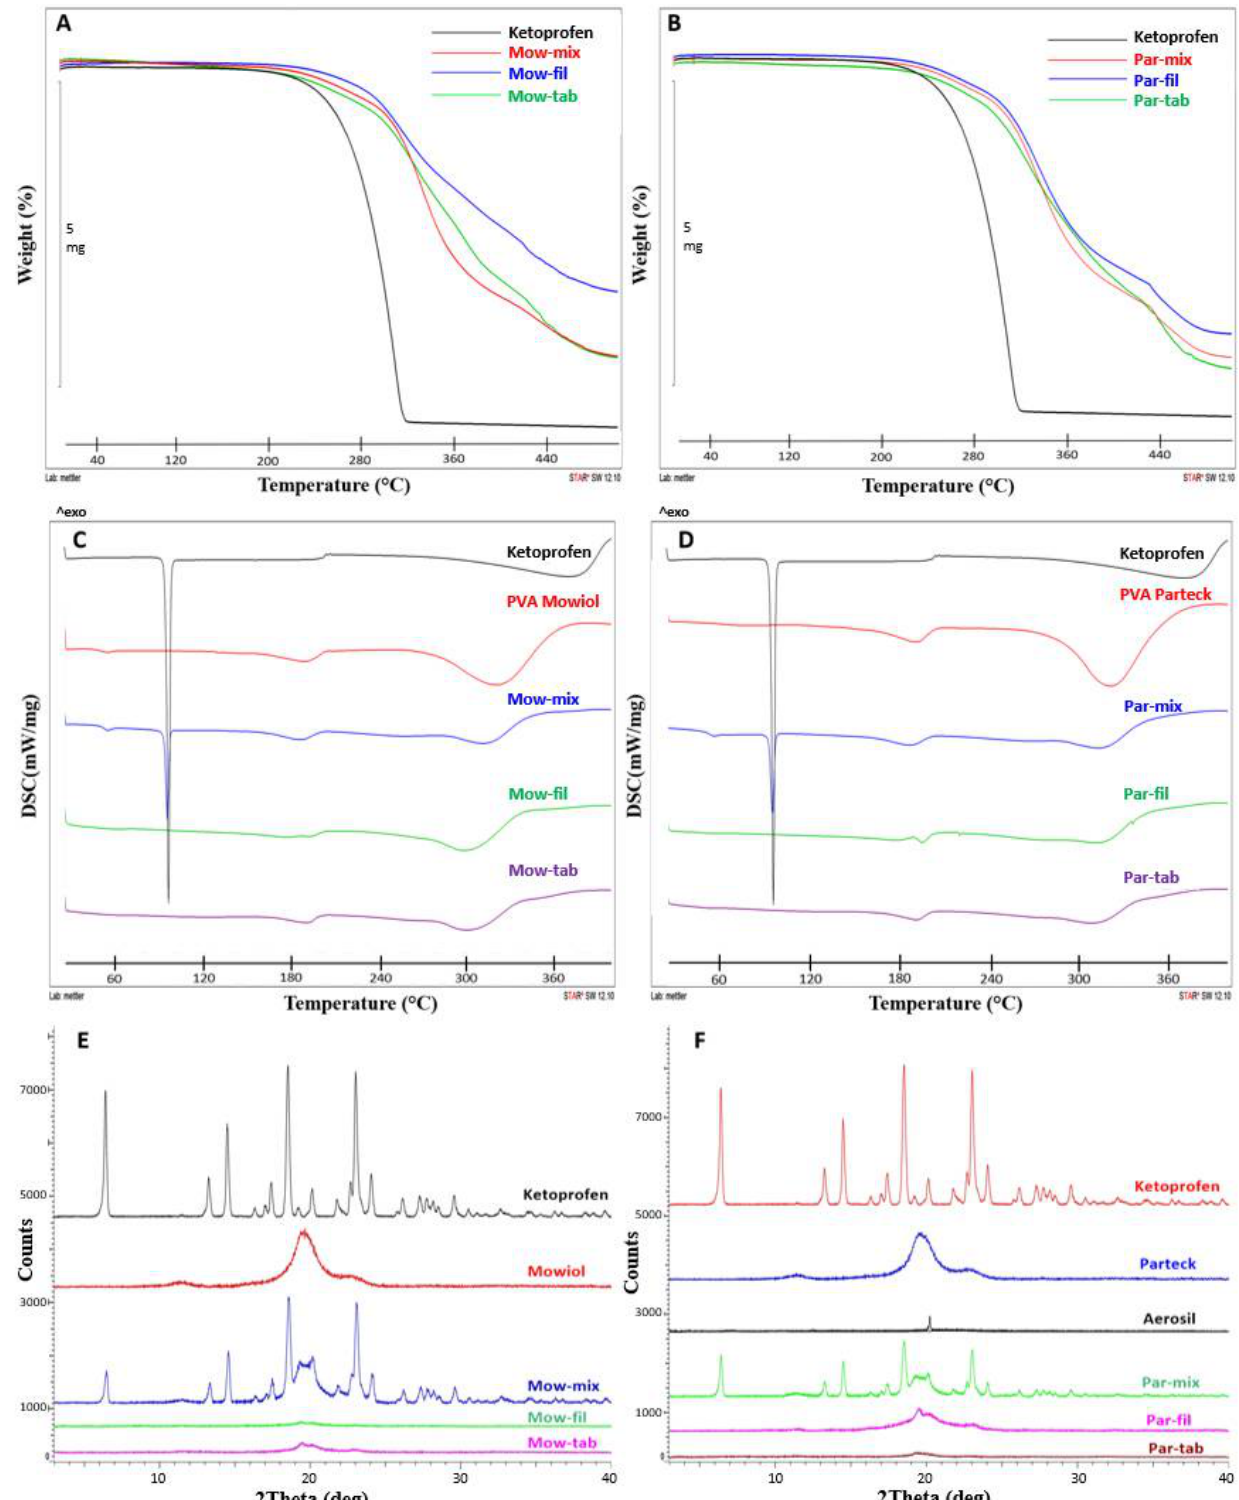
Figure 3. Physical characterization of raw materials, physical mixtures, filaments and 3DP tablets: ( A , B ) TGA profiles; ( C , D ) DSC thermograms; ( E , F ) X-Ray diffractograms.